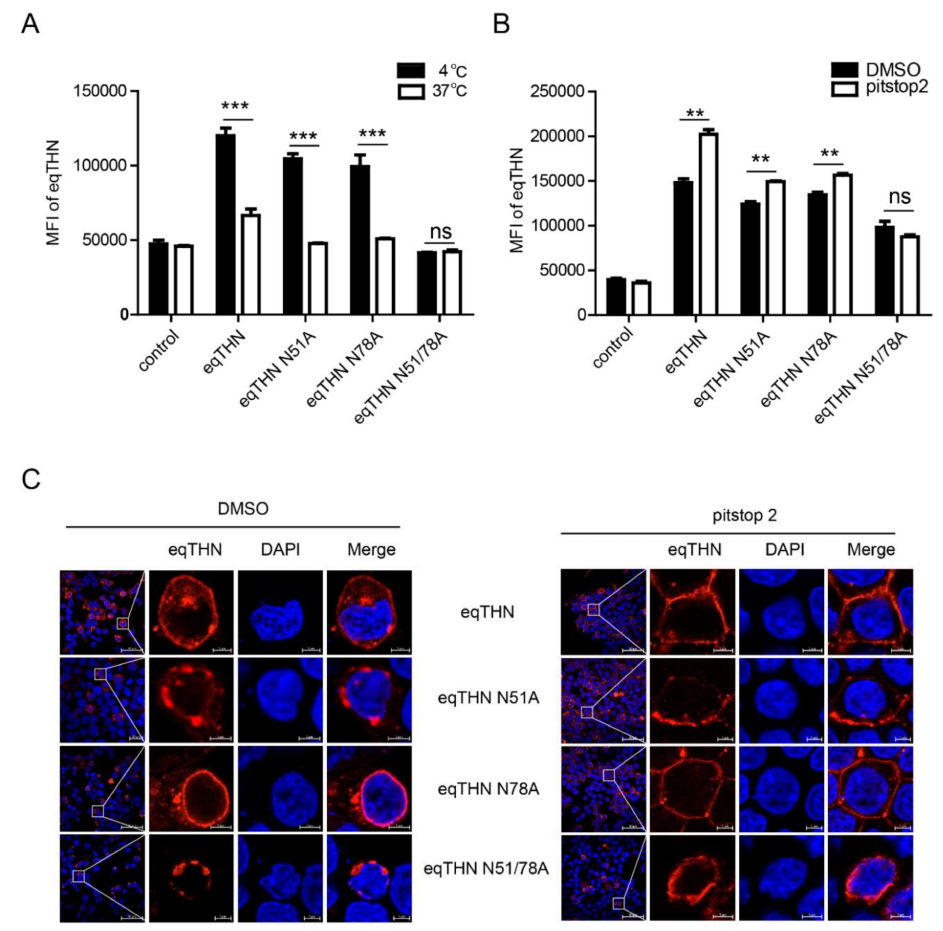
Figure 5. N-glycosylation modification mediates the anterograde tra ffi cking of eqTHN in the cell. ( A ) HEK293T cells were transfected with 1 µ g of either pcDNA-eqTHNe-FLAG or its N-glycosylation mutants. Cells were stained with an anti-FLAG antibody and the antibody uptake was determined at 4 ◦ C and 37 ◦ C by flow cytometry. ( B ) HEK293T cells transfected with 1 µ g of plasmids expressing either WT eqTHN or its N-glycosylation mutants, and 1 µ g of plasmid expressing pcDNA3.1-FLAG as a control. At 8 h posttransfection, pitstop2 (20 µ M) were added to the supernatant and incubated for 16 h and dimethyl sulfoxide (DMSO) as a control, then the cells were harvested and the mean fluorescence intensity of eqTHN on the cell surface was analyzed by flow cytometry using an anti-FLAG antibody. ( C ) HEK293T cells transfected with 1 µ g of plasmids expressing either WT eqTHN or its N-glycosylation mutants. At 8 h posttransfection, pitstop2 (20 µ M) were added to the